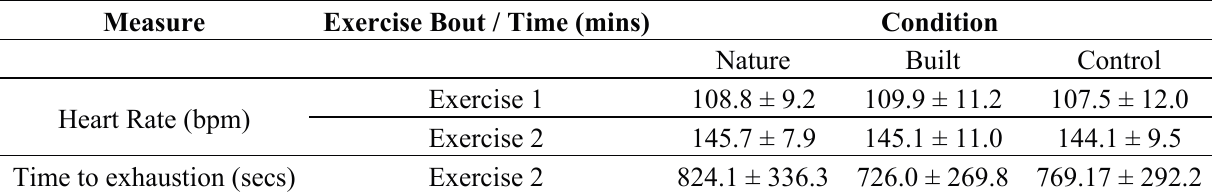
Table 1. Mean (± SD) results for heart rate and time to exhaustion by condition. Measure